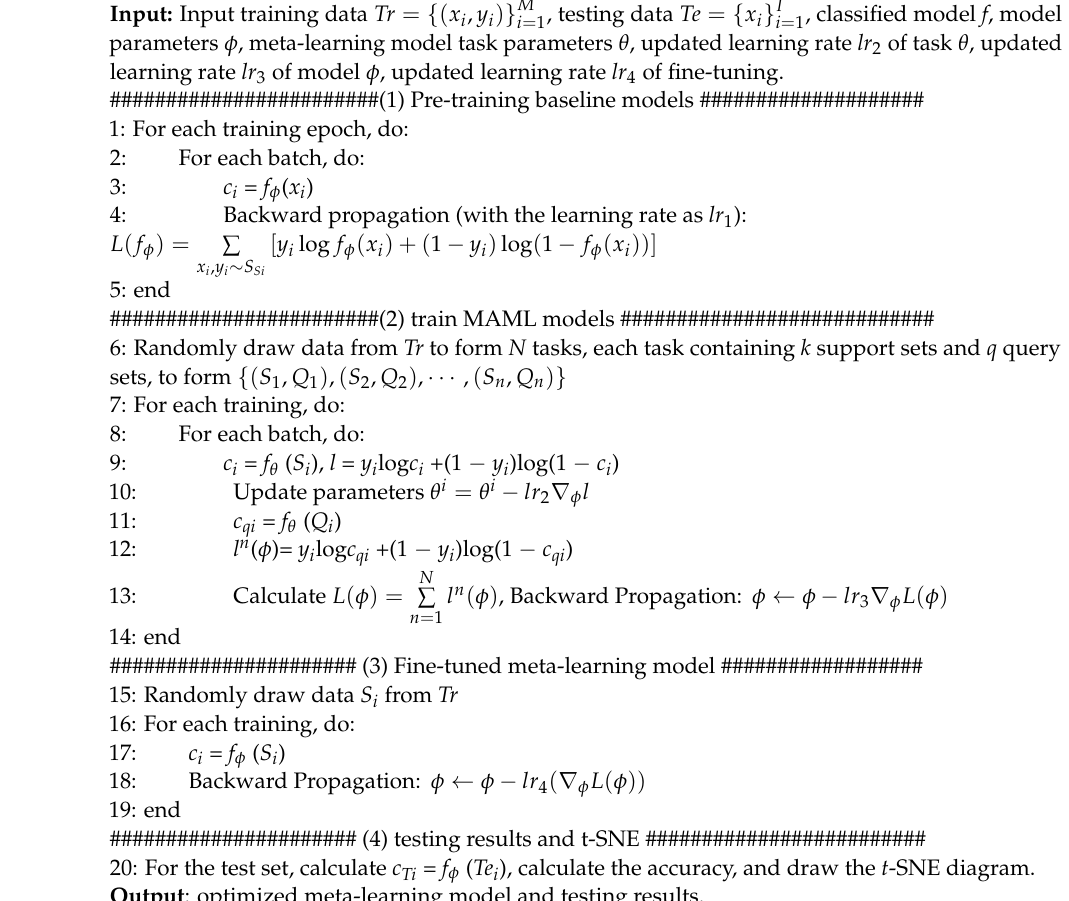
Algorithm 1. few-shot (c-way-k-shot) fault diagnosis based on